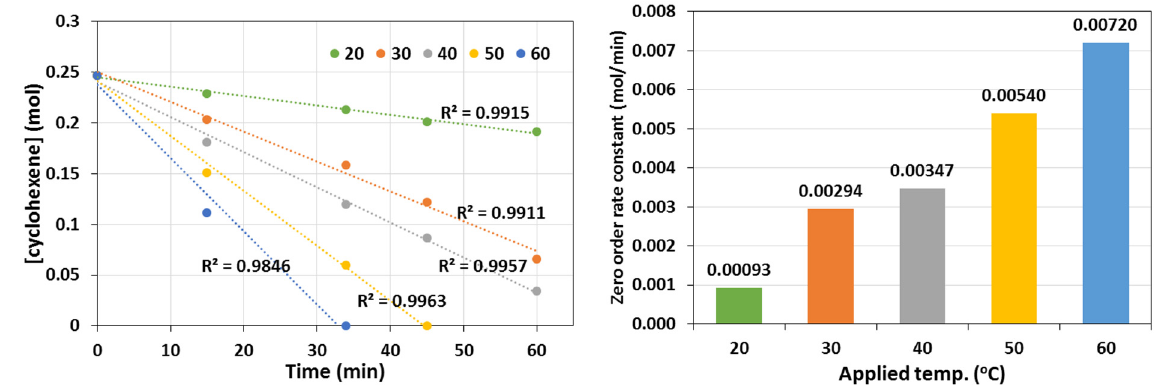
Figure 10. Left panel: The zero-order kinetic model for the hydrogenation of cyclohexene over Pt-ZSM-5 at different reaction temperatures. Right panel: comparison between the calculated zero-order rate constants.